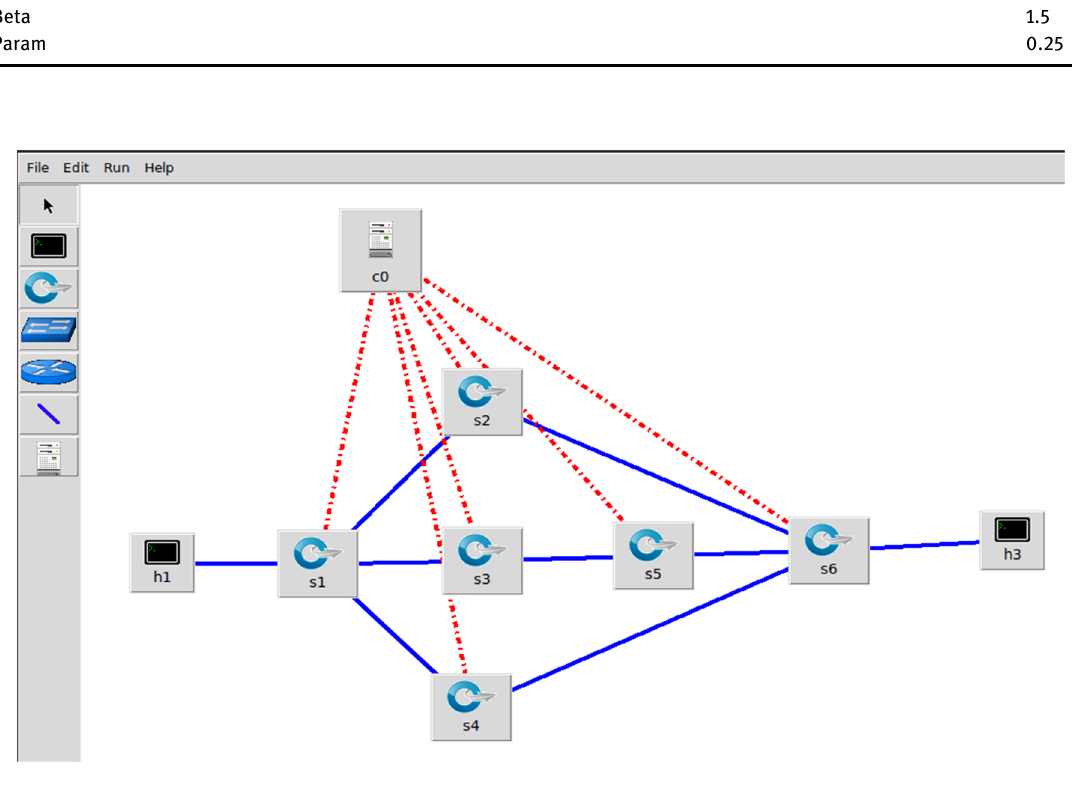
Figure 3: Network topology 1.